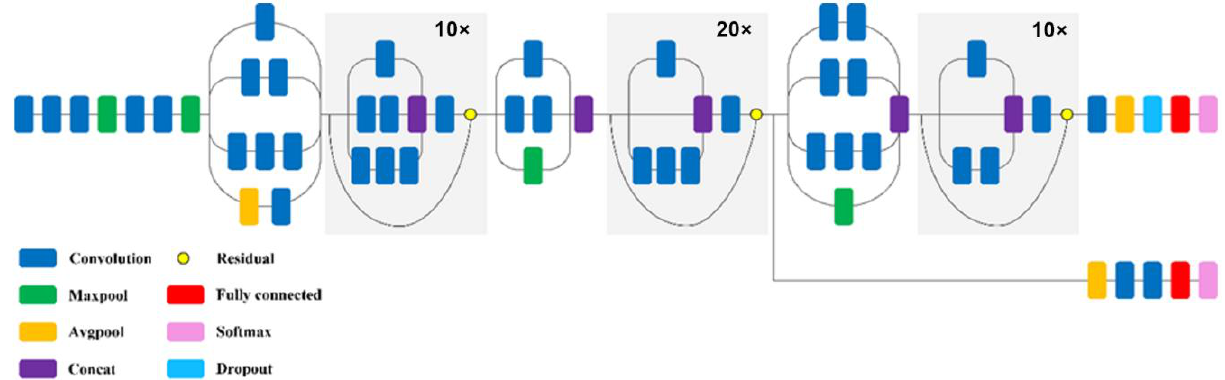
Figure 8. Simplified structure of the InceptionResNetV2 network model [47].